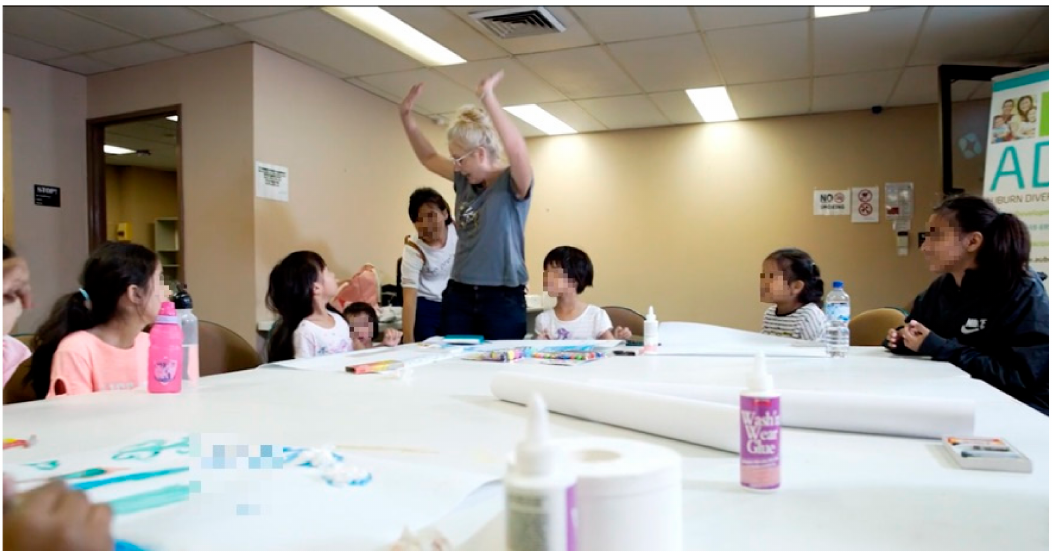
Figure 1. Making and belonging: children and researcher share stories of home. RMIT University Human Ethics Clearance Number